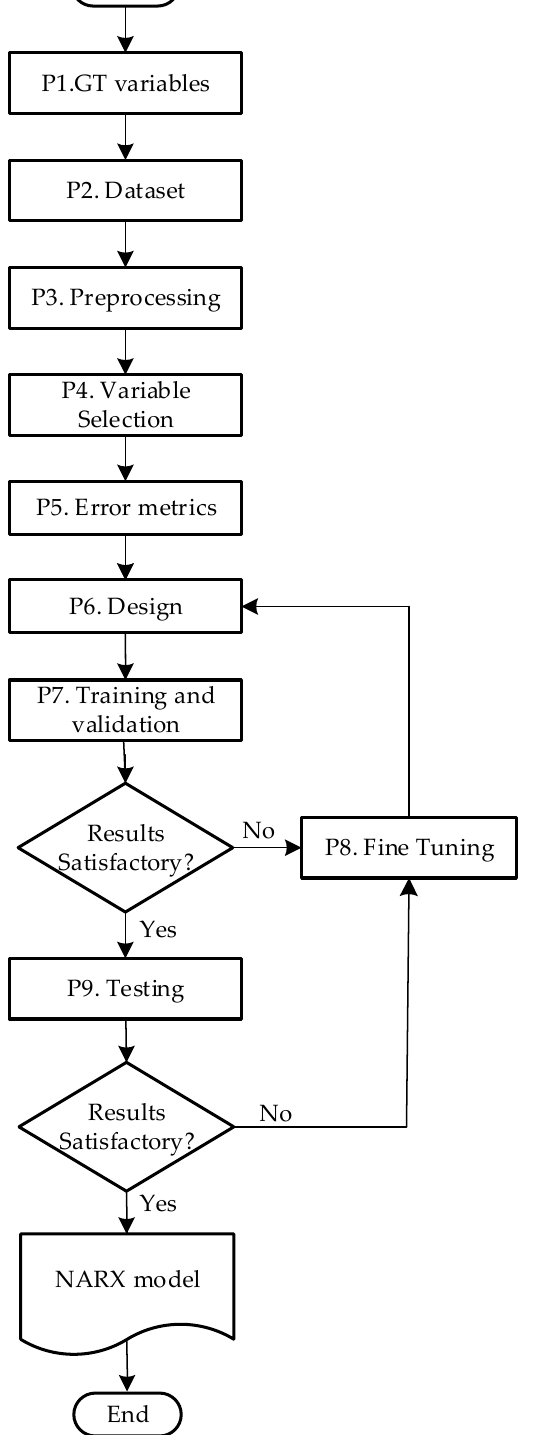
Figure 4. Method for the systematic design of NARX.